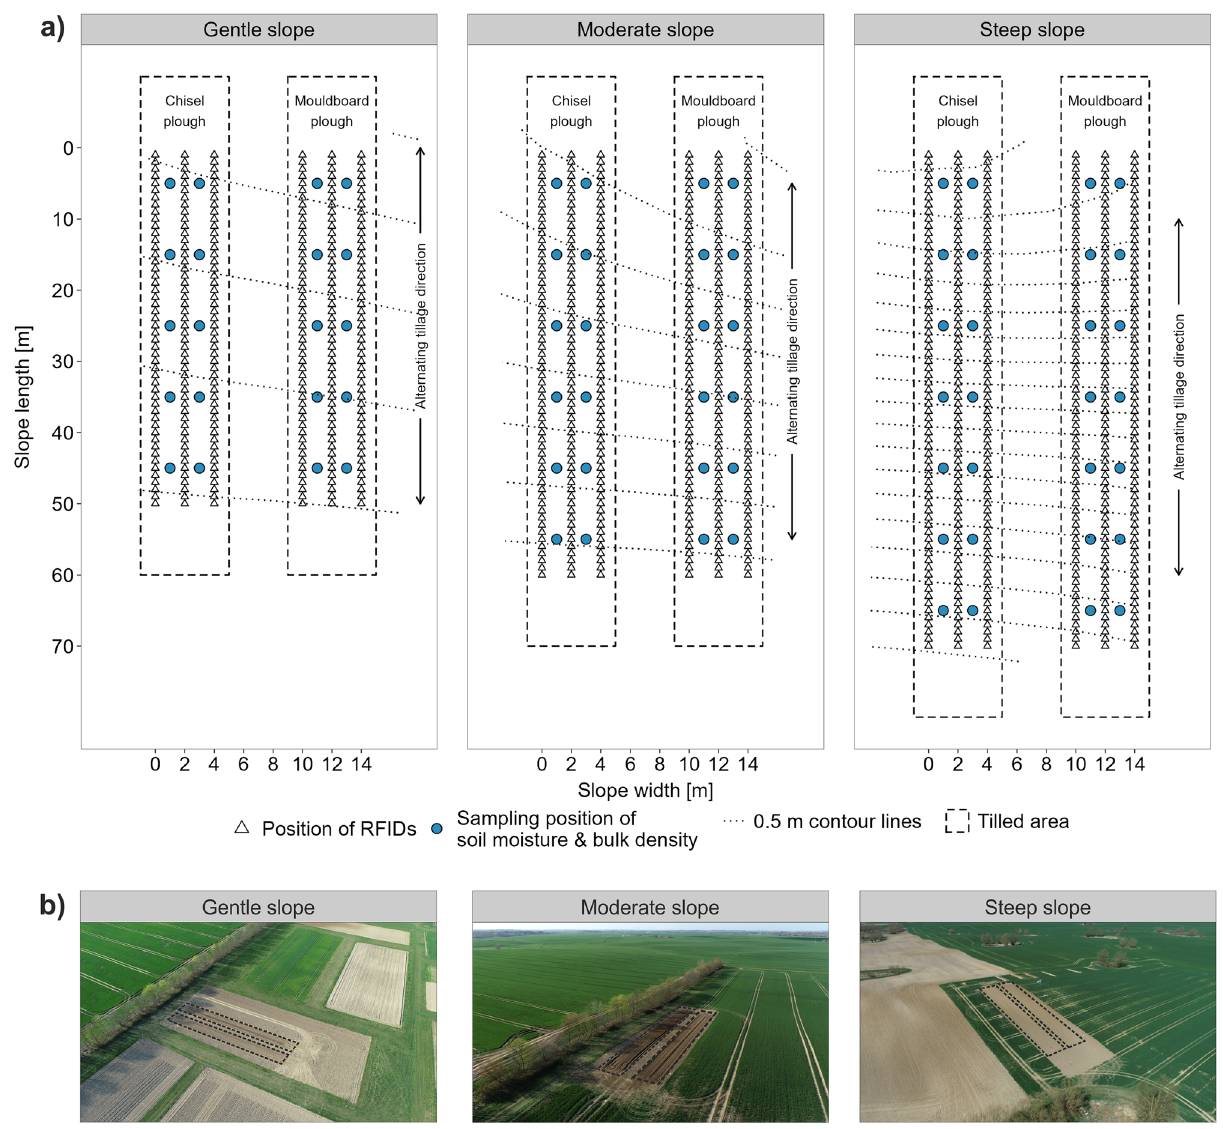
Figure 1. ( a ) Experimental design of the tillage experiments. Separate plots for chisel plough (left) and mouldboard plough (right) tillage next to each other at each of the three experimental sites with gentle, moderate, and steep slope. Three rows of RFIDs (triangles) for each plot with 2 m distance between the rows and 1 m between the RFIDs along the slope. Soil moisture and bulk density were measured in lines between the RFID rows starting after 5 m with 10 m increments (blue dots). Dotted lines indicate contour lines (0.5 m interval). Dashed boxes mark the tilled area, whereby tillage direction was alternating up- and down-slope. Please note the different plot lengths per site. ( b ) Aerial photos of the experimental sites (black dashed boxes) that are located at 53.370546° N 13.800004° E (gentle slope), 53.374694° N 13.799799° E (moderate slope), and 53.421454° N 13.678403° E (steep